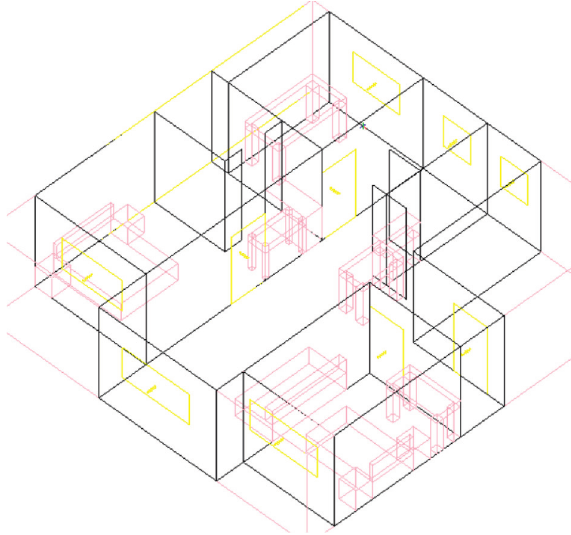
Figure 1: Model of house type A.